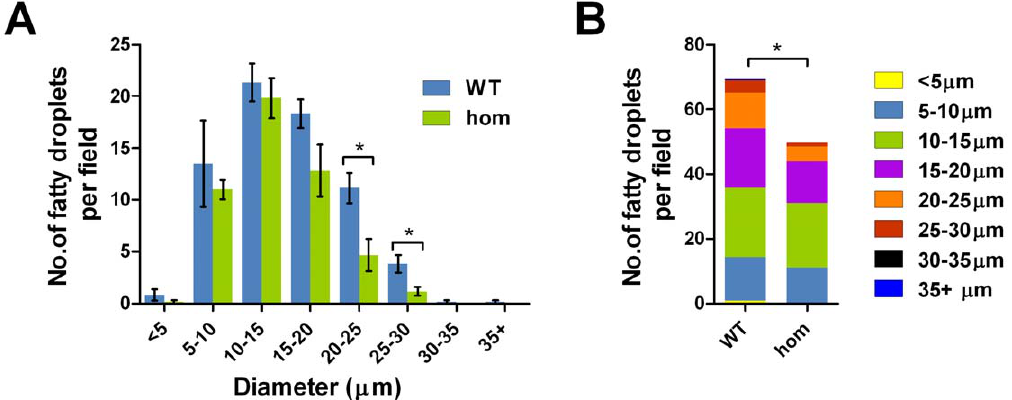
Figure 5. Ablation of NEGR1 causes reduction in fatty droplets. A , B . Number of triglyceride droplets classified into ranges of size in diameter ( m m) in hepatocytes of female Negr1 -I87N mice (n=3 mice per genotype). All data are presented as mean 6 SEM. Student’s t -test (2-tailed) was carried out between groups, *, P , 0.05; **, P , 0.01; ***, P , 0.001.